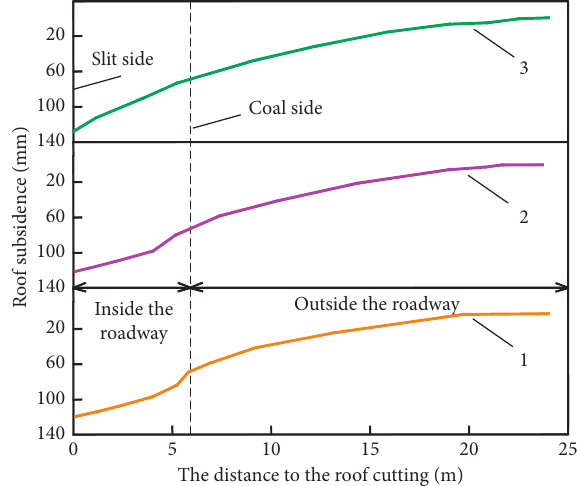
Figure 10: Vertical displacement of the